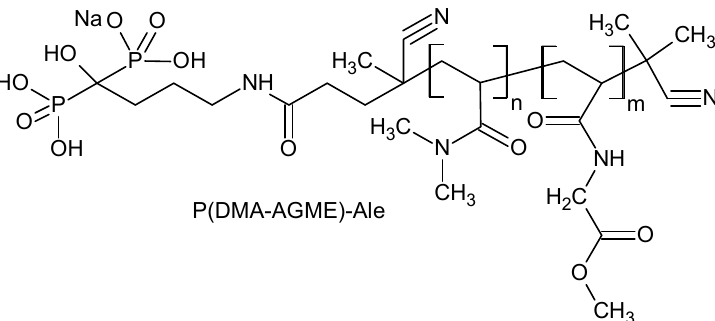
Figure 1. Chemical structure of alendronate-modified poly( N , N -dimethylacrylamide- co-N -acryloylglycine methyl ester).